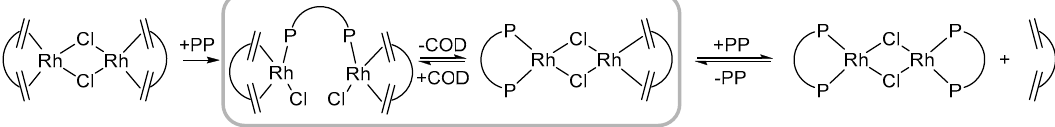
Scheme 6. Schematic representation of the modified ligand exchange mechanism for the formation of the rhodium precatalyst [Rh(diphosphine)( µ 2 -Cl)] 2 .